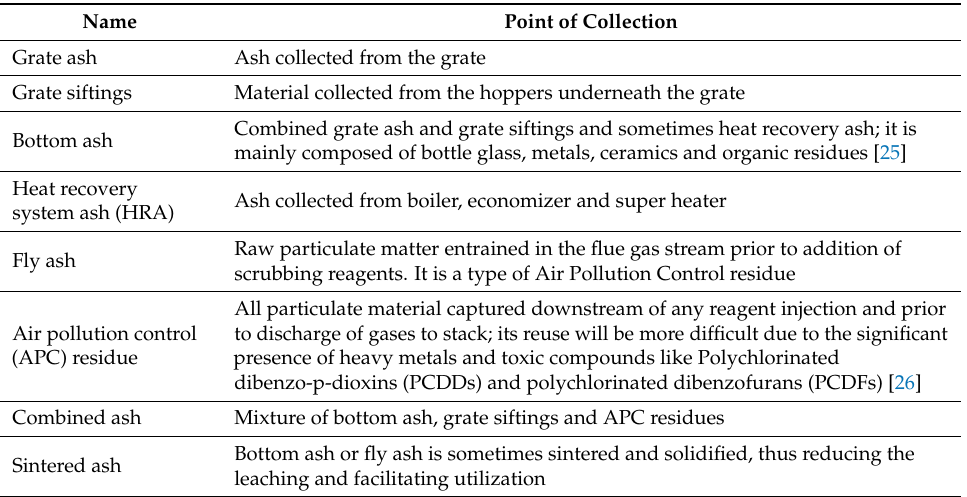
Table 1. Nomenclature of waste streams from MSWI ash